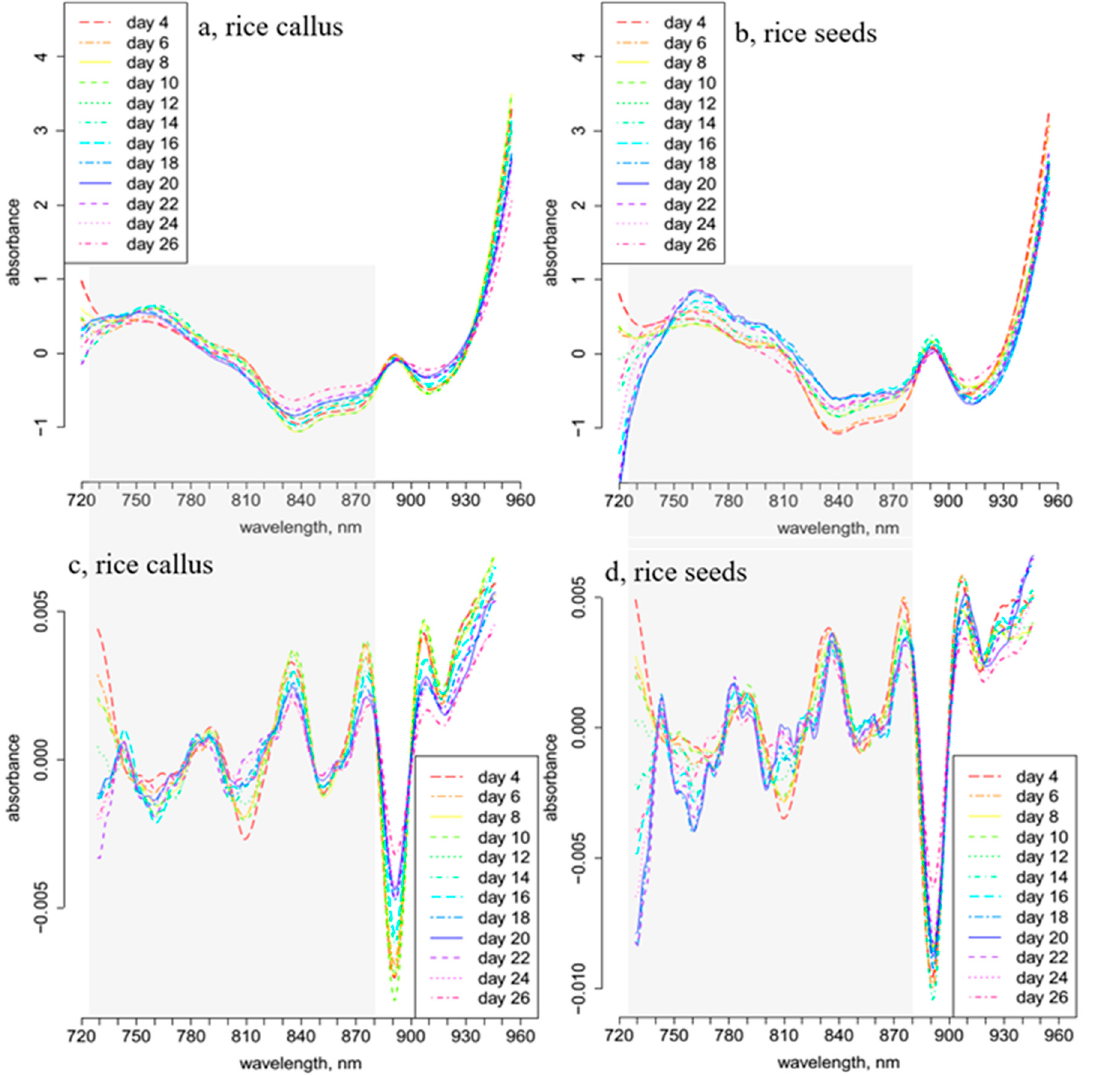
Figure 1. Smoothed, standard normal variate (SNV)-transformed and linear detrend-corrected daily average transmittance spectra of ( a ) 28 callus samples, ( b ) 28 rice seedlings; 2nd derivative of the daily average spectra of ( c ) 28 callus samples and ( d ) rice seedlings.